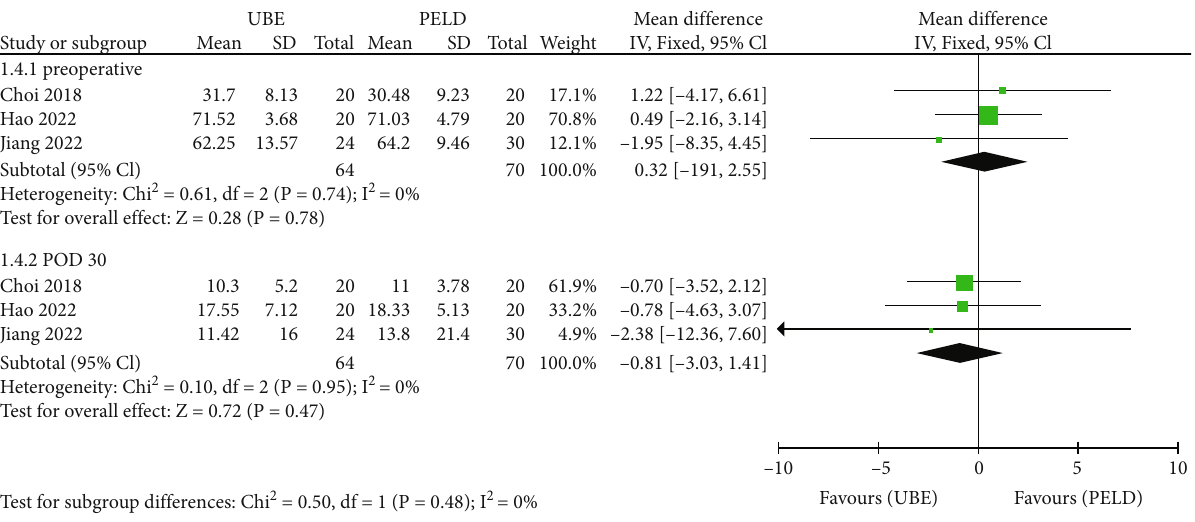
Figure 6: Forest plots for ODI at preoperative/postoperative 30